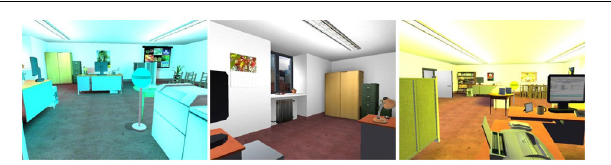
FIGURE 1 | Virtual office illuminated in two different lights (right in blue and left in yellow) which served as conditioned stimuli (CS) and with normal illumination (ISI, inter-stimulus